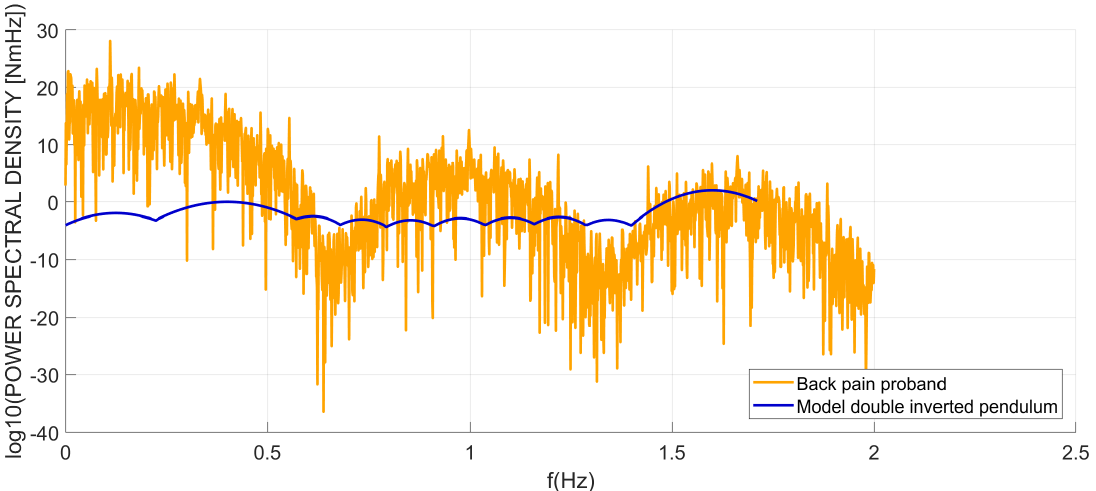
Figure 9. Logarithmic representation of the power density spectrum of the back pain group (Korff > 4) and a double inverted pendulum (DIP model shown in the range of 0–1.7 Hz) adapted from Günther et al. 2011 page 296 and 297 [15].